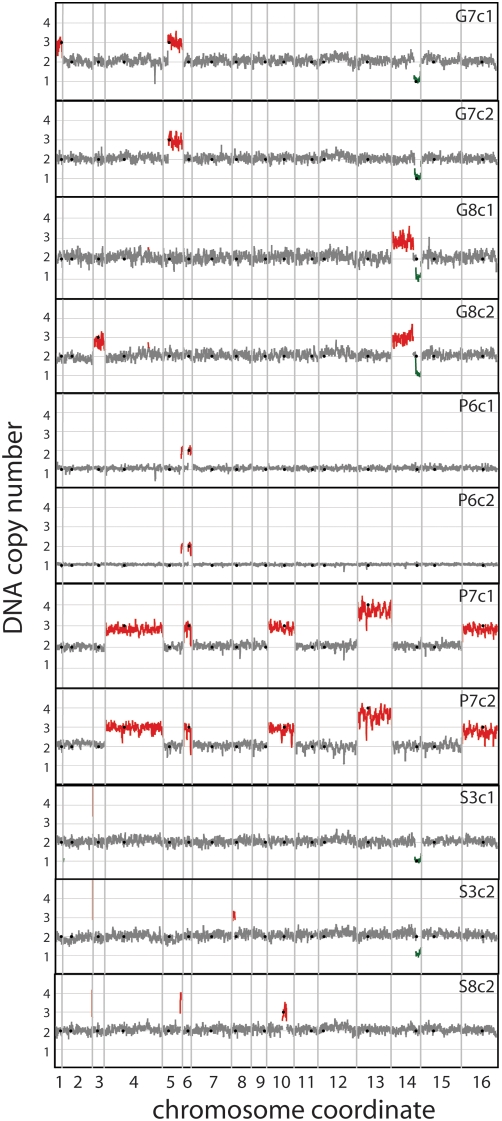
Structural genomic variation is detected in clones selected from all long-term nutrient limitations.We computed a running average of log2 ratios between evolved and ancestral genomes determined using CGH across 7 consecutive genes. Contiguous regions deviating from wildtype ploidy levels are colored red for amplifications and green for deletions. Regions that did not deviate from wildtype copy number are in gray. Centromeres of each of the 16 chromosomes are indicated by black dots.